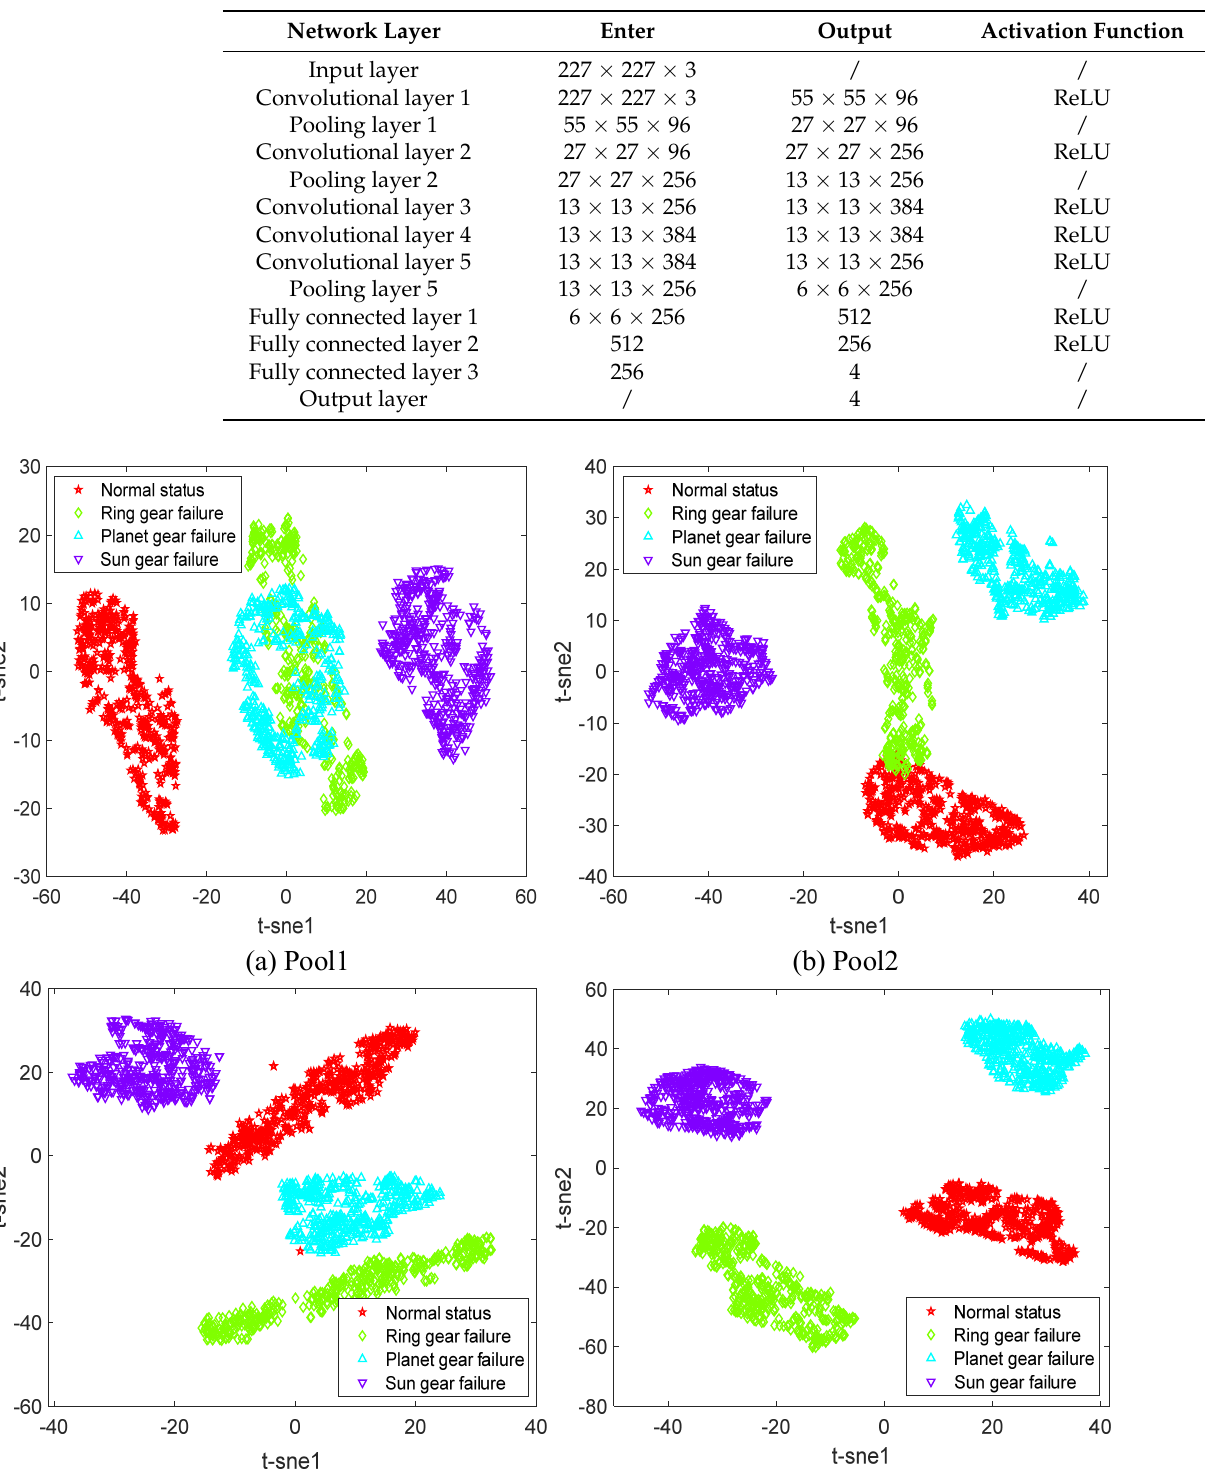
Table 4. AlexNet network model parameter settings.